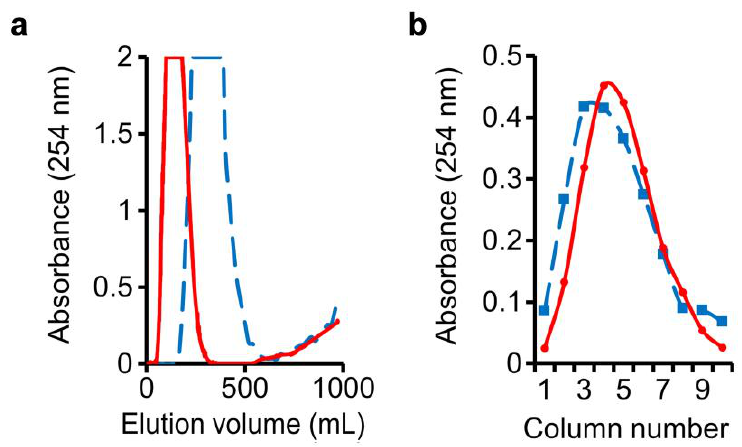
Figure 2. Separation of benzyl alcohol and o-cresol: ( a ) Benzyl alcohol peak in mobile-phase eluate was followed by beginning elution of o-cresol; ( b ) o-Cresol distribution in the stationary phases drained from individual separation columns. Solid line: regular setup; dashed line: high dead-volume setup.